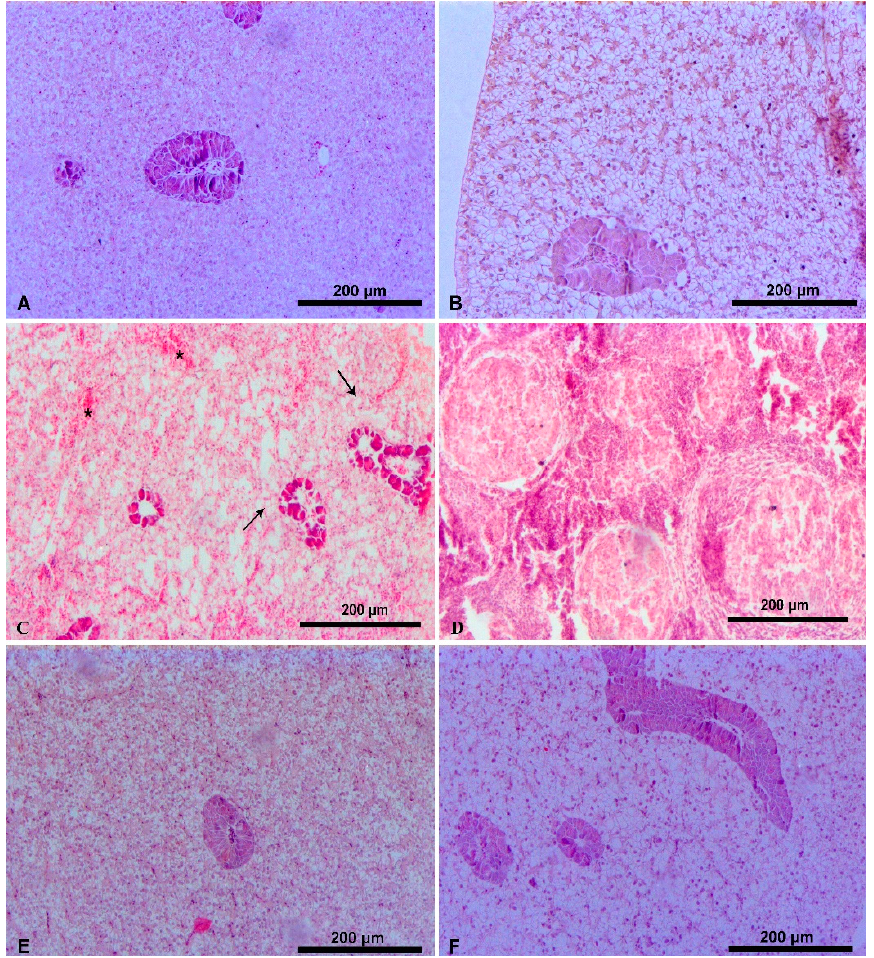
Figure 2. Liver histopathological examination of S. aurata fed on HFM diets. ( A ) fish fed FM diet—normal liver structure; ( B ) fish fed HFM25 diet—normal liver structure; ( C ) fish fed HFM100 diet—hemorrhage signs (*) and large lipid droplets (arrows); ( D ) fish fed HFM100 diet—signs of liver cirrhosis; ( E ) fish fed HFM25+ diet—normal liver structure; ( F ) fish fed HFM50+ diet—hepatocytes with no central nuclei were detected. Table 2. Sequencing results, diversity indices and coverage values of fish fed the FM, PBM50 and HFM50